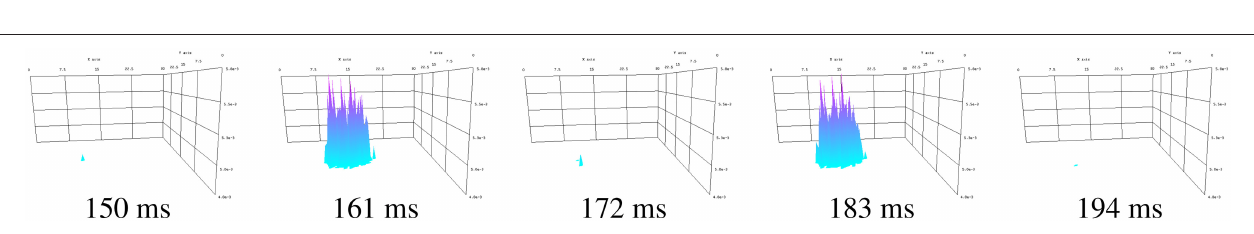
FIGURE 4 | Two cycles of the breather